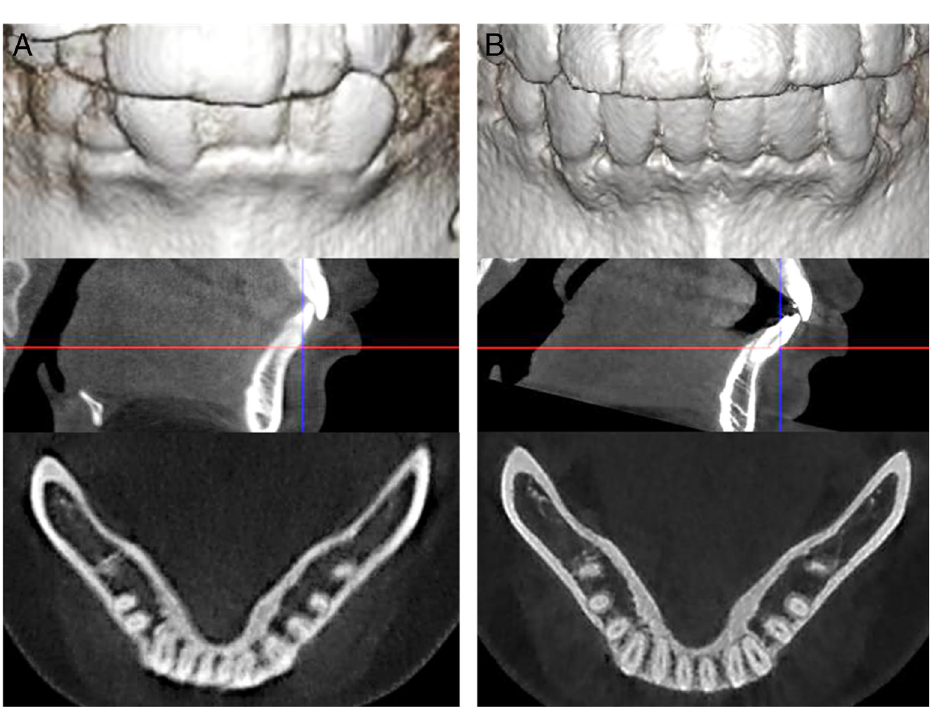
Figure 11. Cone-beam computed tomographic images to identify the labial alveolar bone thickness: (A) Pre-treatment; (B)